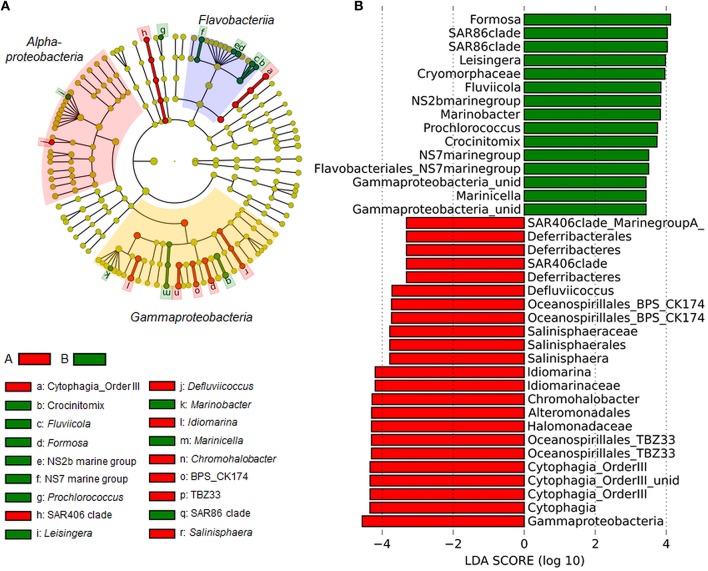
Linear discriminant effect size analysis (LEfSe) results on bacterioplankton communities. (A) Taxonomic representation of statistically consistent differences between group A and B. Differences are represented in the color of the group, where the OTU is most abundant. Colored areas mark the most prominent bacterial classes found during this study. Red, Alphaproteobacteria; Yellow, Gammaproteobacteria; Blue, Flavobacteriia. (B) Histogram of linear discriminant analysis (LDA) scores computed for OTUs, differently abundant in group A and B. LDA scores can be interpreted as the degree of consistent difference in relative abundance between the two groups. The histogram thus identifies which OTUs among all those detected as statistically different explain the greatest difference between group A and B.